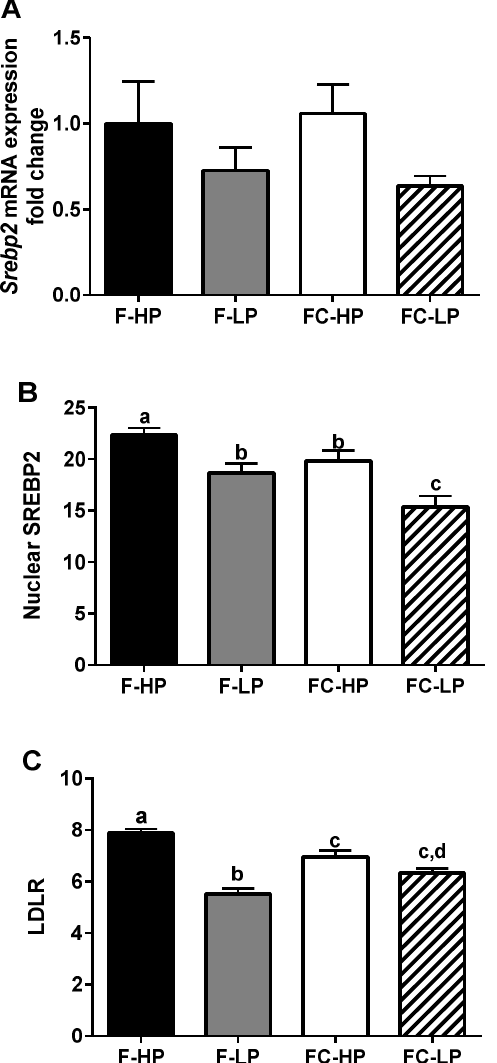
Figure 4. Srebp2 mRNA fold change ( A ) and nuclear protein expression ( B ), and LDLR protein expression ( C ) in the liver of piglets fed different infant formulas containing high (F-HP) or low (F-LP) PS concentrations, supplemented with cholesterol (FC-HP, FC-LP) to achieve concentrations similar to human breast milk. Data are means ± SEM, n = 8/diet group. Statistical differences were determined by two-way ANOVA; for Srebp2 mRNA, p = 0.056 for PS, p = 0.833 for cholesterol, and p = 0.427 for interaction; for SREBP2, p < 0.001 for PS, p = 0.004 for cholesterol, and p = 0.673 for interaction; for LDLR, p < 0.001 for PS, p = 0.881 for cholesterol, and p < 0.001 for interaction. Student Newman-Keuls post hoc analysis. Bars without a common letter significantly differ from each other, p <